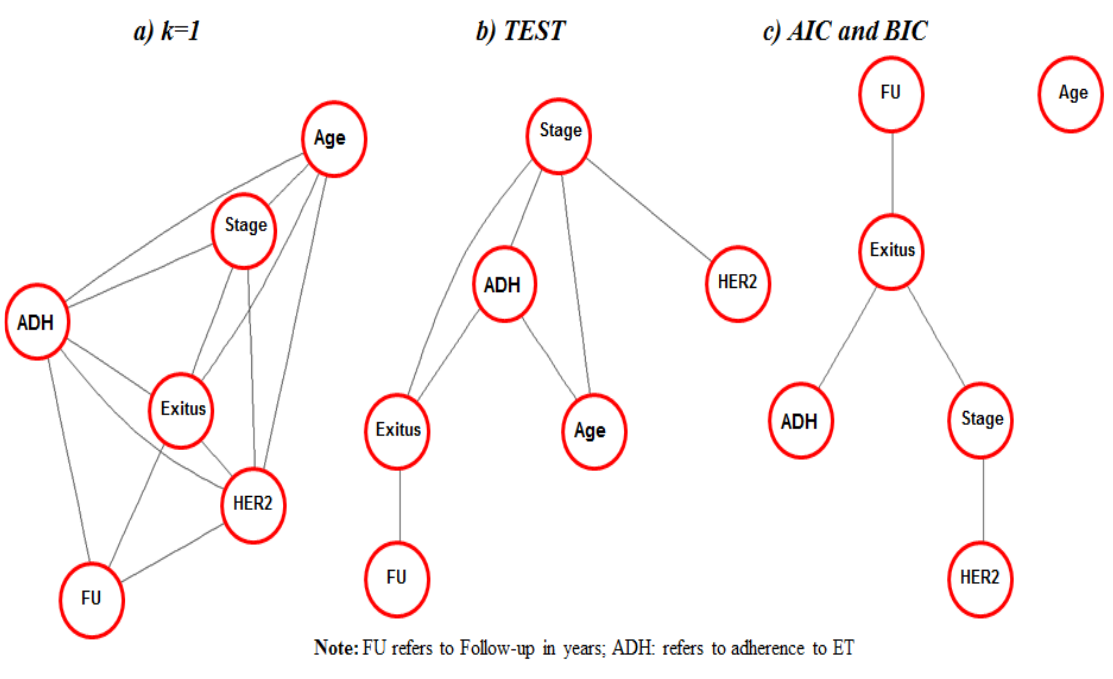
Figure 2. Undirected acyclic graphs generated from fitting the best graphical models to observed data (N = 1243) using different criterions: ( a ) GMK1 model: k-penalty factor of penalized log-likelihood set to 1; ( b ) GMTEST: testing for statistical significance of arches; ( c ) GMAIC: Akaike information criterion (BIC) and GMBIC: Bayesian information criterion (BIC).